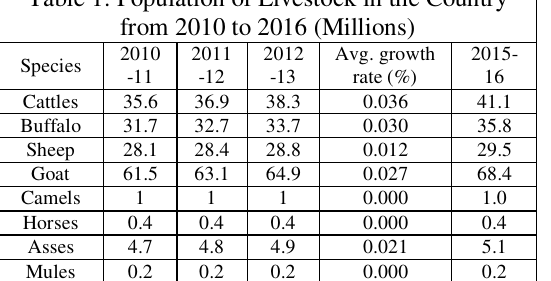
Table 1: Population of Livestock in the Country from 2010 to 2016 (Millions)